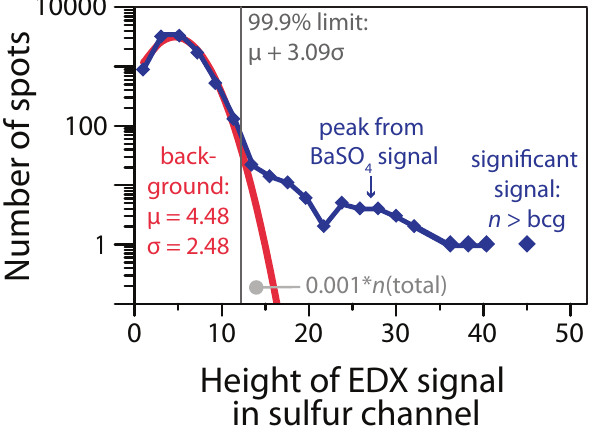
Fig. 4. Frequency of signal height in the sulfur channel of an auto- matic EDX analysis of BaSO 4 on a gold-coated filter. The measured signal for the sulfur channel is shown in blue and the Gaussian fit to the contribution from the gold peak is shown in red.